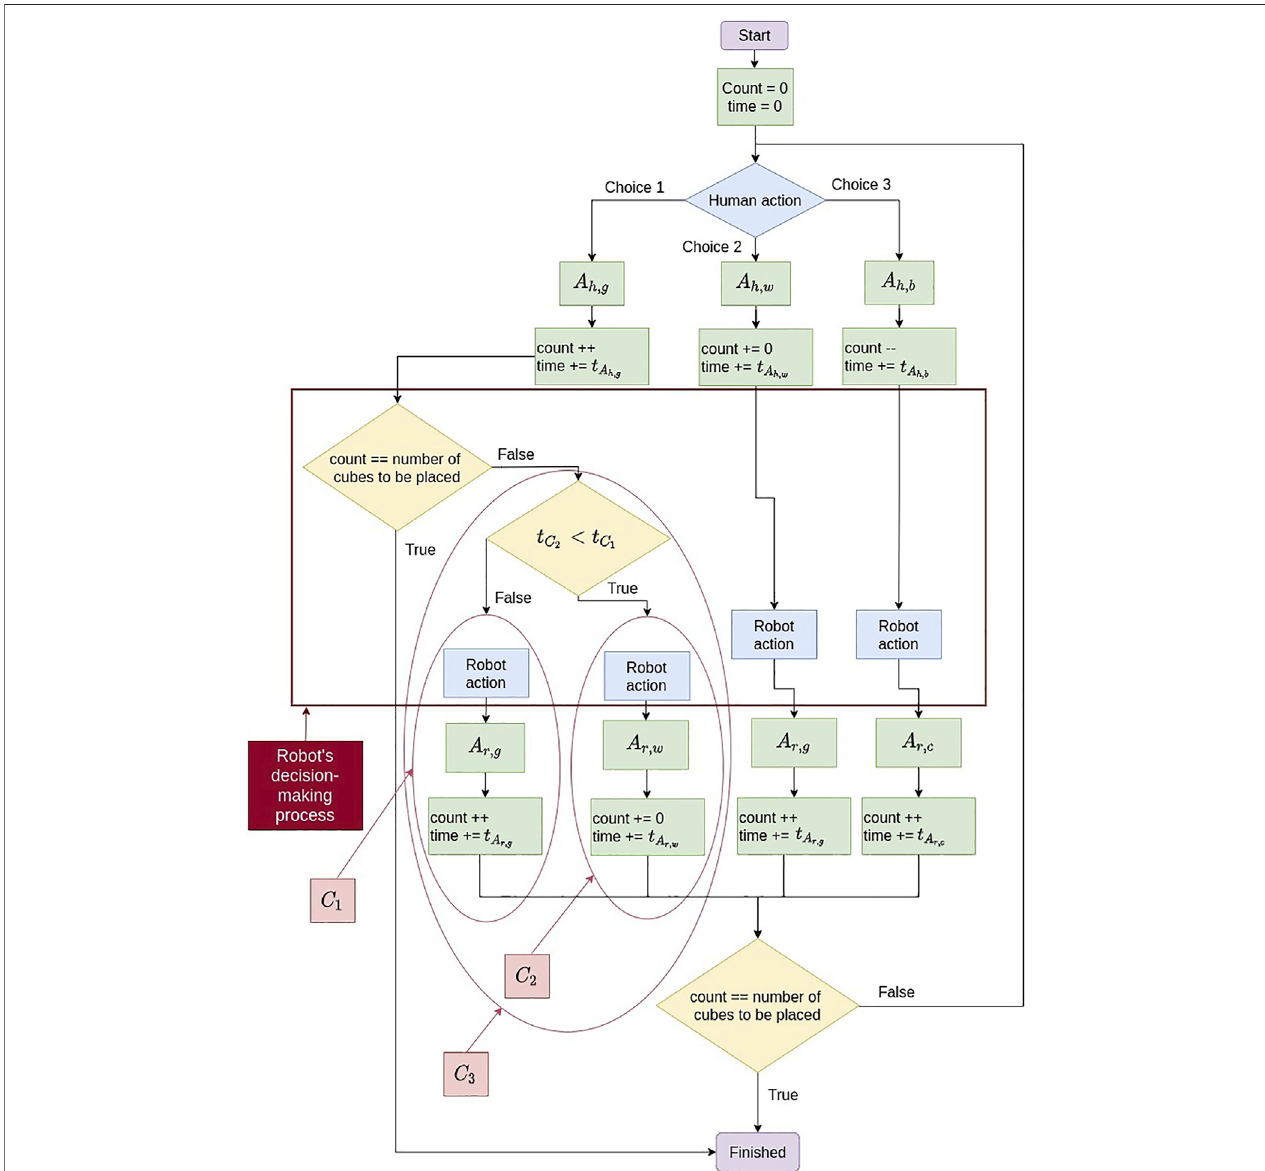
FIGURE 6 | C 3 algorithm block